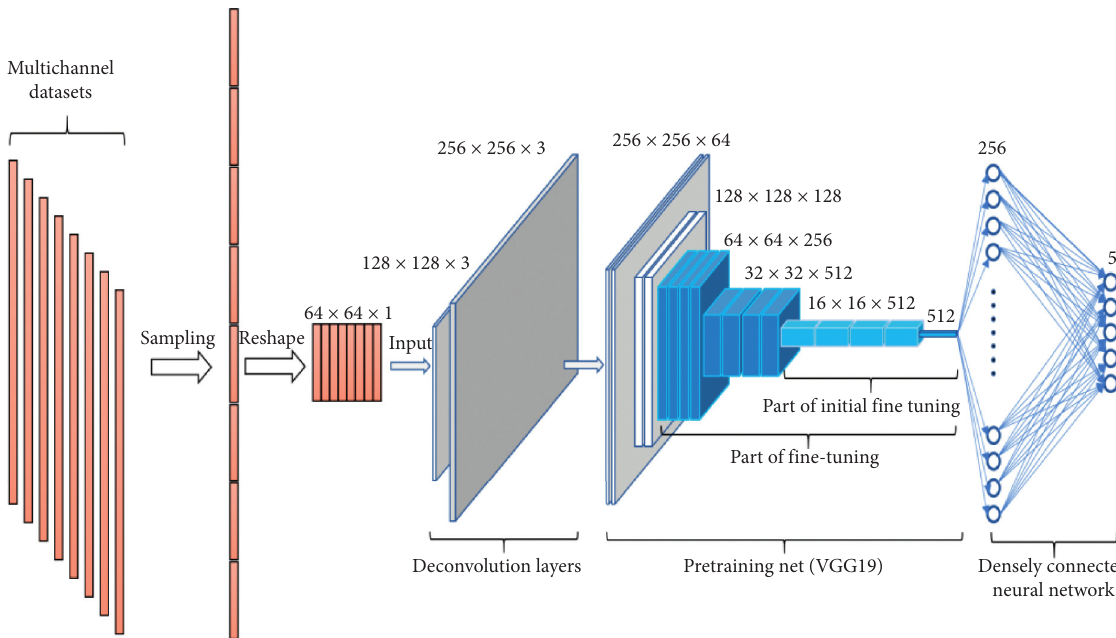
Figure 4: The flow of the proposed mechanical fault